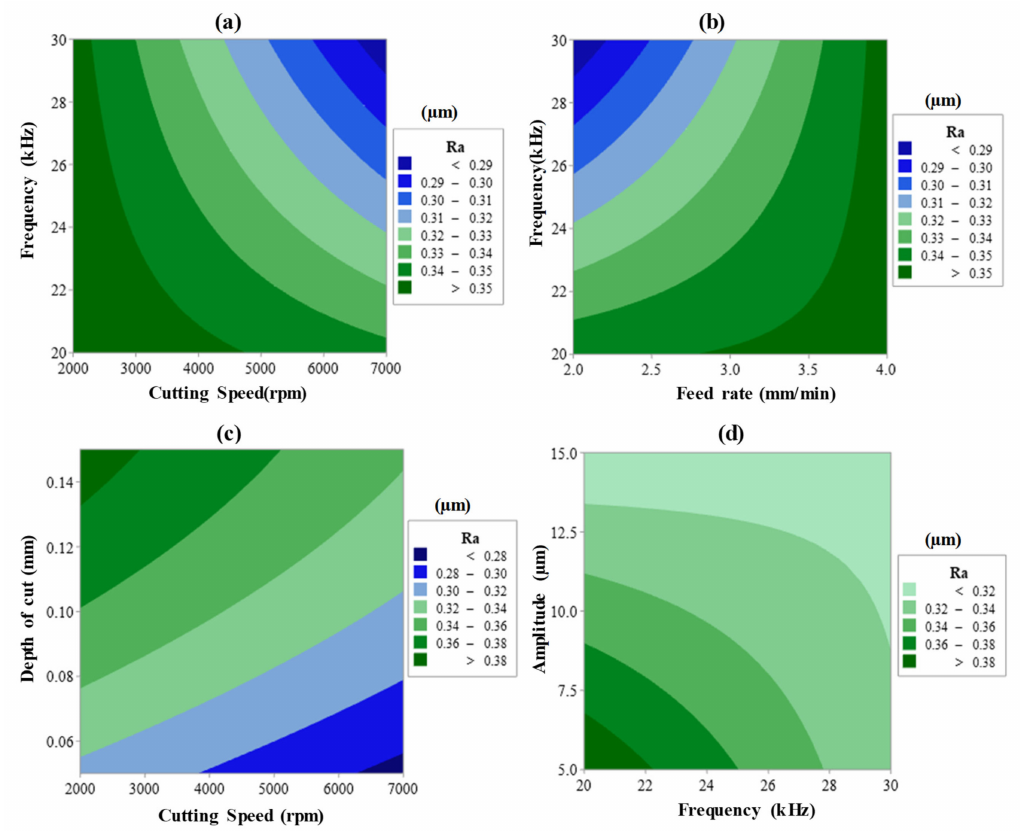
Figure 8. Two variable interactive e ff ects of ( a ) cutting speed × frequency, ( b ) feed rate × frequency, ( c ) cutting speed × depth of cut, and ( d ) frequency × amplitude on